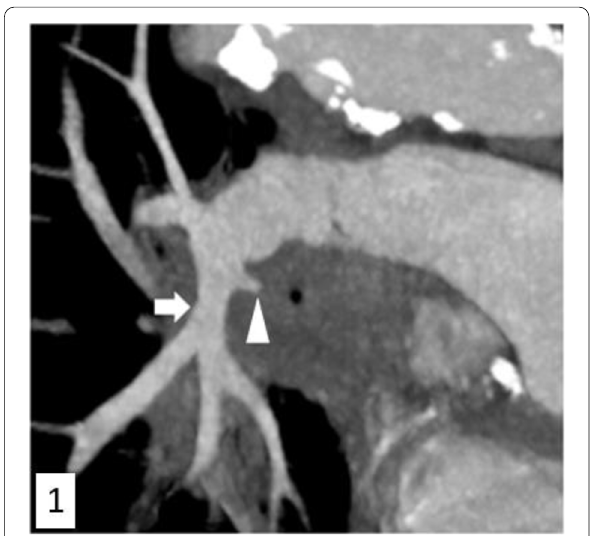
Fig. 1 Treatment of a ruptured pulmonary artery pseudoaneurysm with a stent graft. Sagittal reconstruction of a computed tomography angiography before embolization shows a pseudoaneurysm ( arrow head ) arising from the left inferior pulmonary artery root ( arrow ).